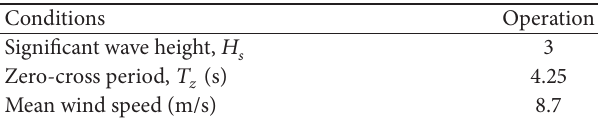
Table 1: Environmental